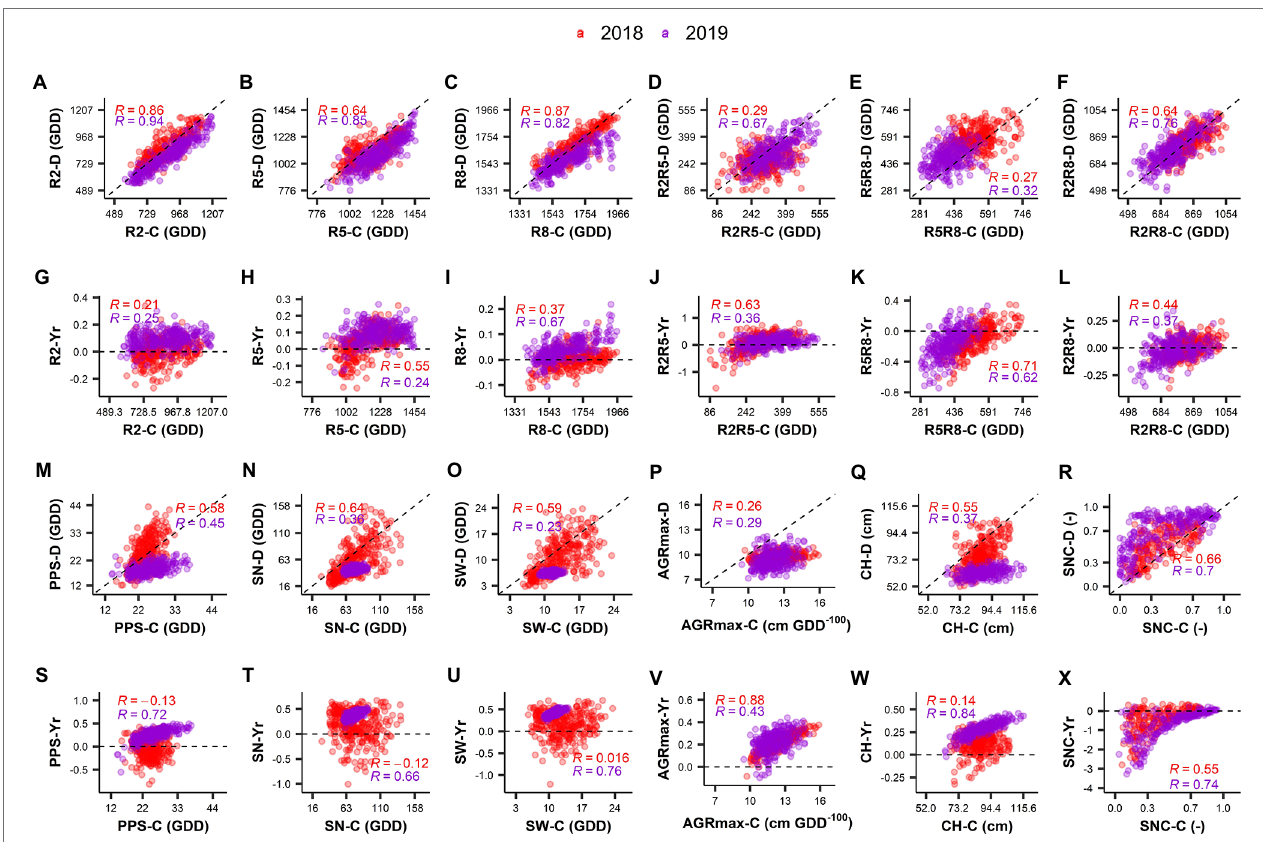
FIGURE 4 | Correlation between BLUP values obtained in the control and drought treatments (A–F,M–R) and between drought index and control treatment (G–L,S–X) for the different traits in the 2 years investigated (2018 and 2019). “- (C) ” and “- (D) ” in the Y -axis labels represent the trait in control treatment and in drought treatment, respectively. “-Yr” in the labels of the Y -axis represents the drought index value for the respective trait. “R” value is the Pearson’s correlation coefficient. Different colors represent the year of the experiment. R2: Thermal time from sowing to full flowering; R5: Thermal time from sowing to beginning seed; R8: Thermal time from sowing to pod maturity; R2R5: Duration of pod formation; R5R8: Duration of seed development; R2R8: Thermal time from full flowering to pod maturity; PPS: Number of pods on the main stem; SN: Number of seeds per plant; SW: Seed weight per plant; Maximum absolute growth rate; CH: Maximum canopy height; SNC: Rate of